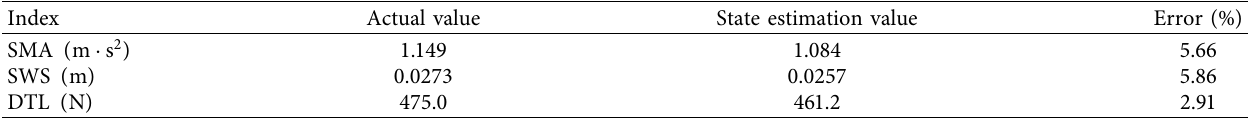
Table 4: RMS of the suspension performance